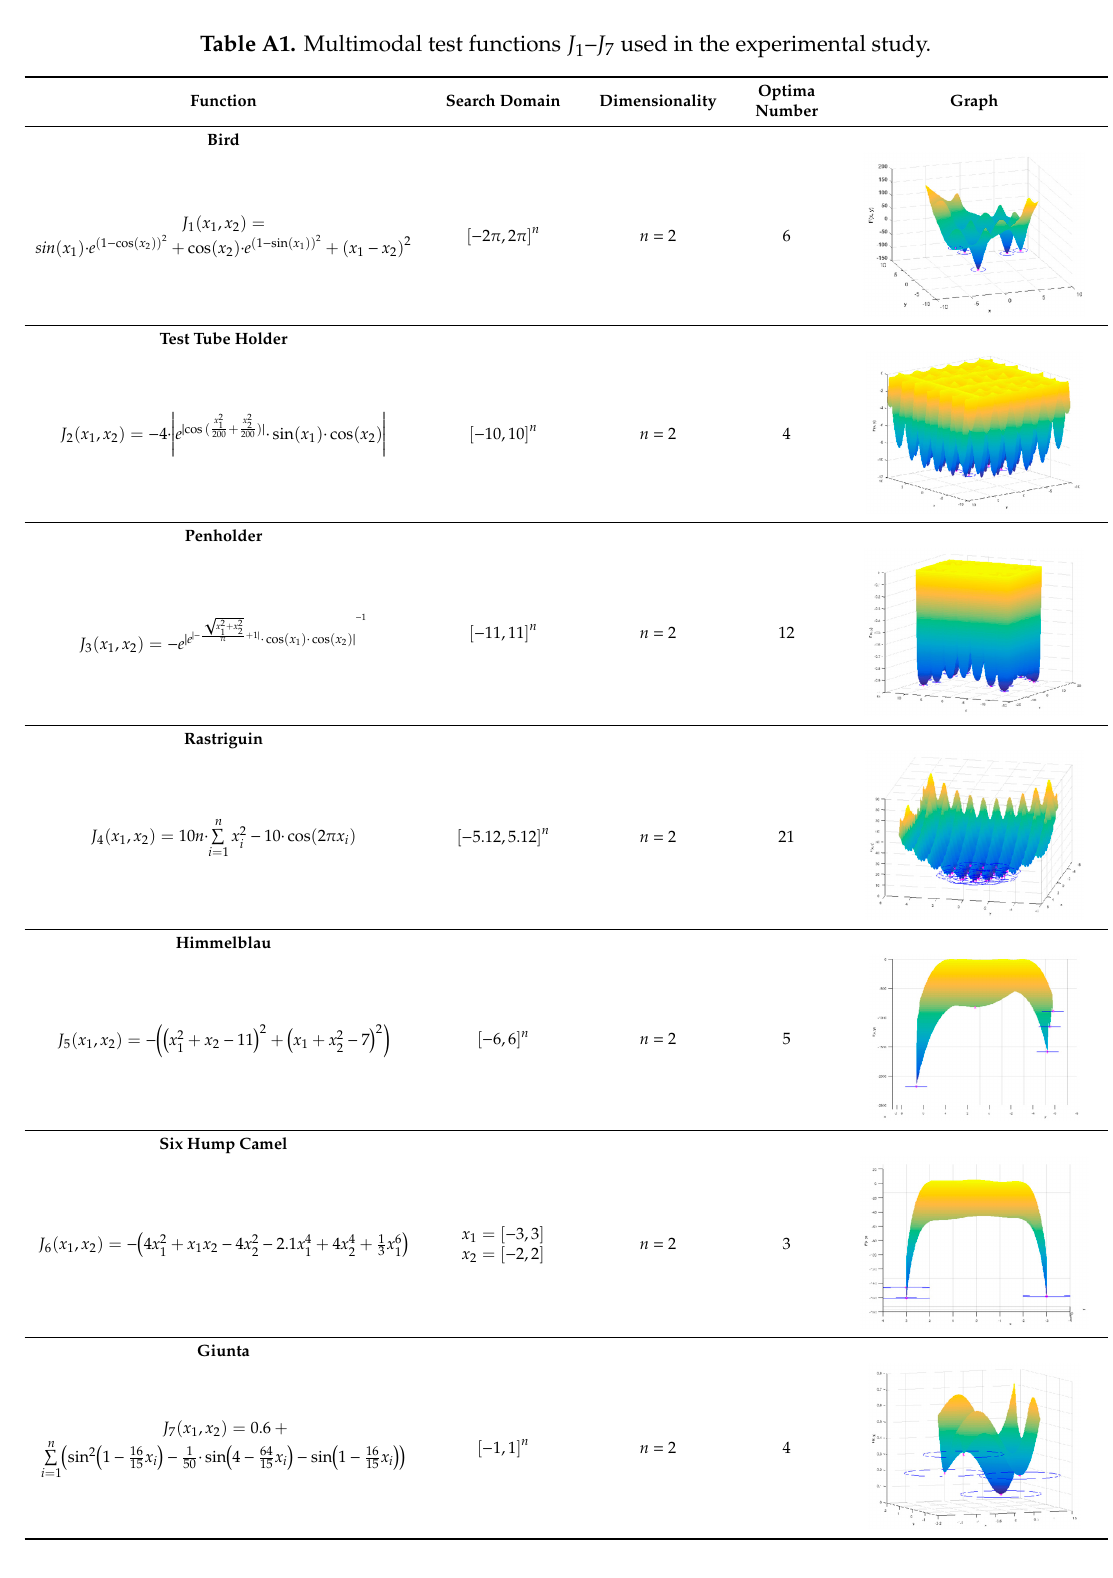
− used in the experimental 1 7 J J